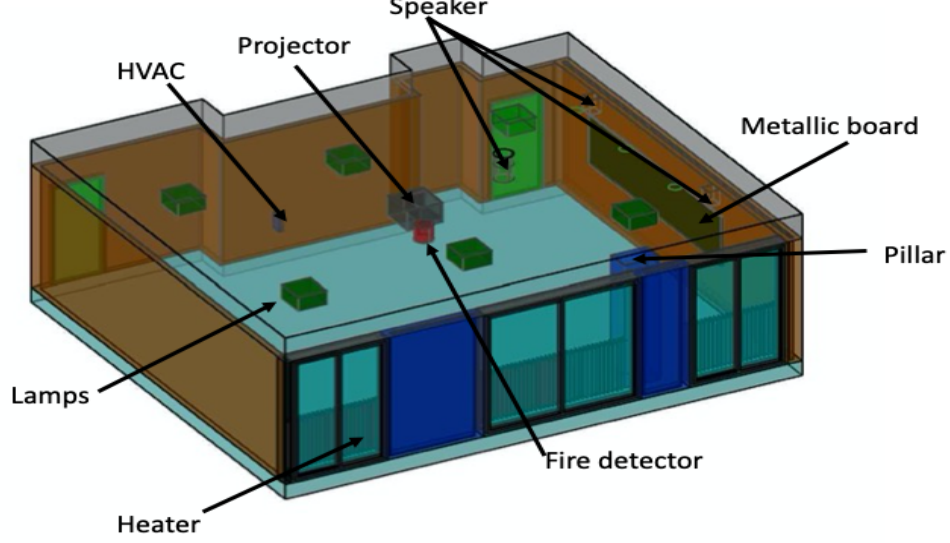
Figure 10. Three-dimensional layout of the classroom.